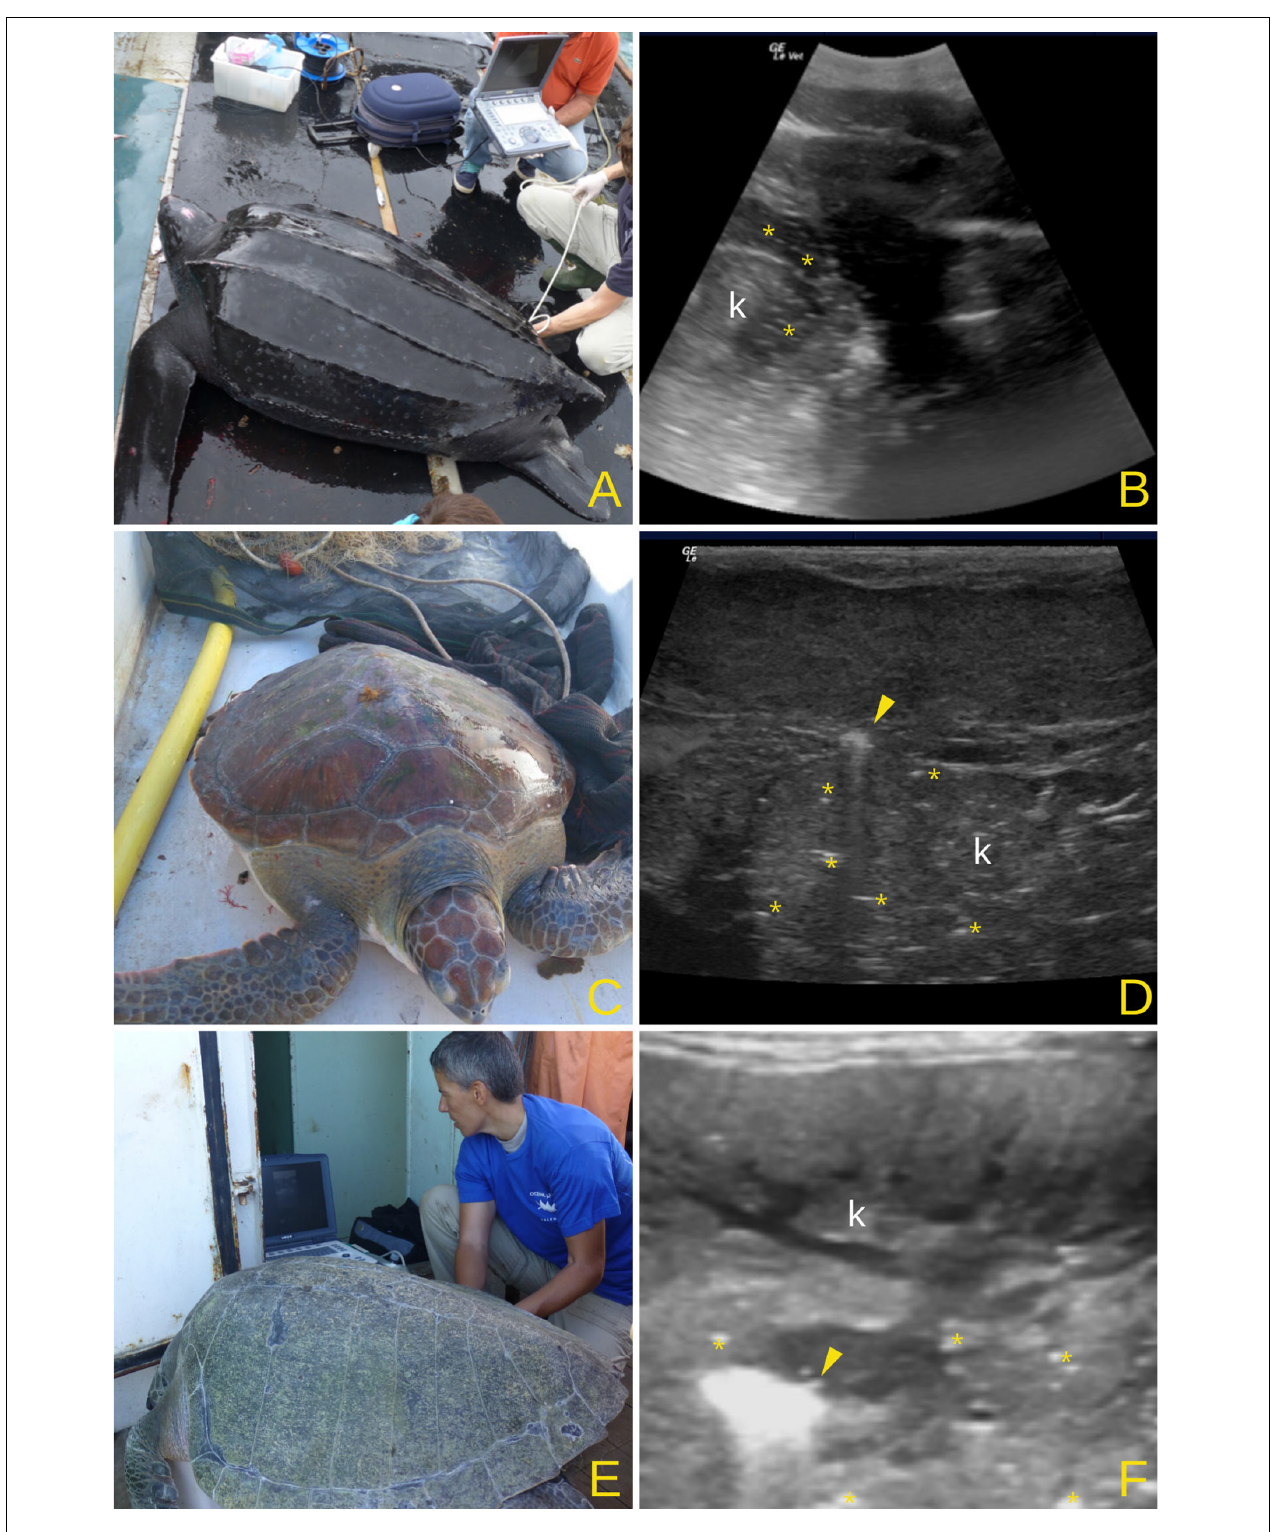
FIGURE 1 | Leatherback turtle (A) , green turtle (C) , and olive ridley (E) on the deck of the fishing boats. Kidney (k) ultrasound in the leatherback (B) , green (D) , and olive ridley (F) turtles showing the presence of gas as a hyperechoic (white) artifacts. Asterisks mark intravascular (B) or intra-parenchymal (D,F) gas seen as small hyperechogenic spots (small bubbles). Larger accumulations of gas usually produce comet tail artifacts on ultrasound examination (arrowhead).